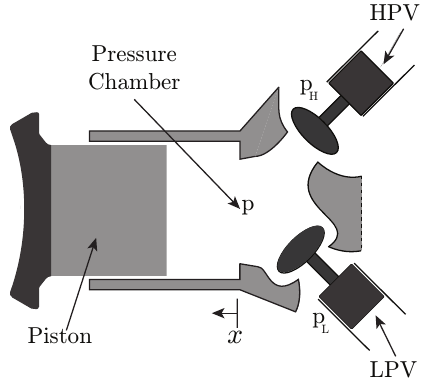
Figure 2: Illustration of the individual pressure cham- ber and the configuration of the correspond- ing